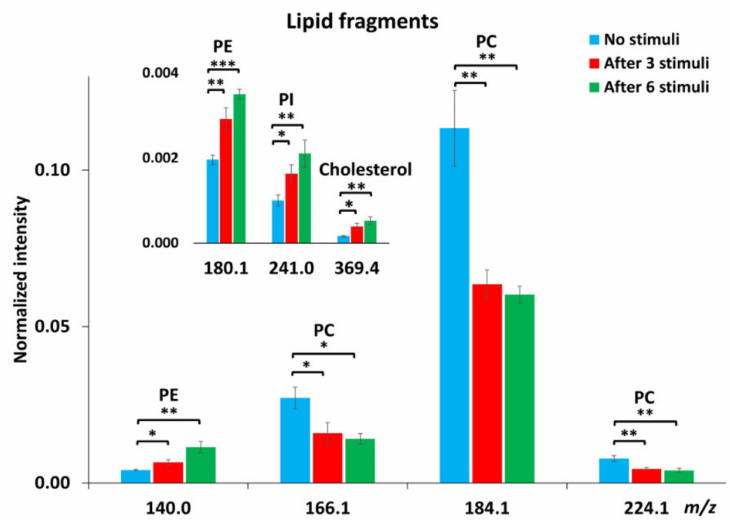
Figure 2. Relative intensities of certain lipid fragments, including PC, PE, phosphatidylinositol (PI) and cholesterol, in PC12 cells with no stimuli, after 3 or 6 repetitive stimuli analyzed with a Bi 3 ++ ion source in positive and negative ion modes. The intensity of individual peaks was normalized to the number of pixels and total peak intensity. Error bars represent SEM. A student’s t -test was used to compare between cells with no stimuli and cells after either 3 or 6 stimuli, *: p < 0.05, **: p < 0.01, ***: p < 0.001, n = 3 for the number of experiments with three di ff erent cell generations.